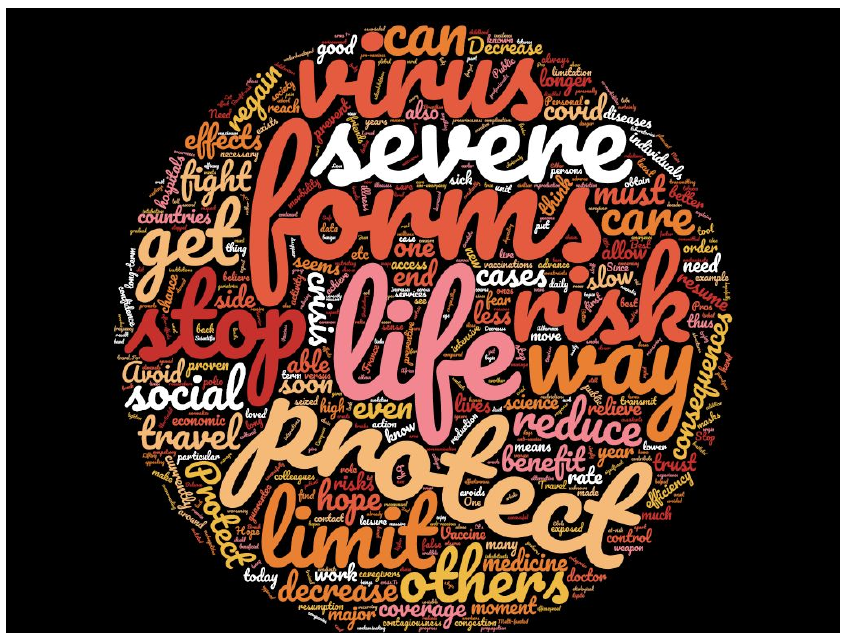
Figure 1. Word cloud from health care workers’ responses to open-ended questions in favor of COVID-19 vaccination. COVID-19